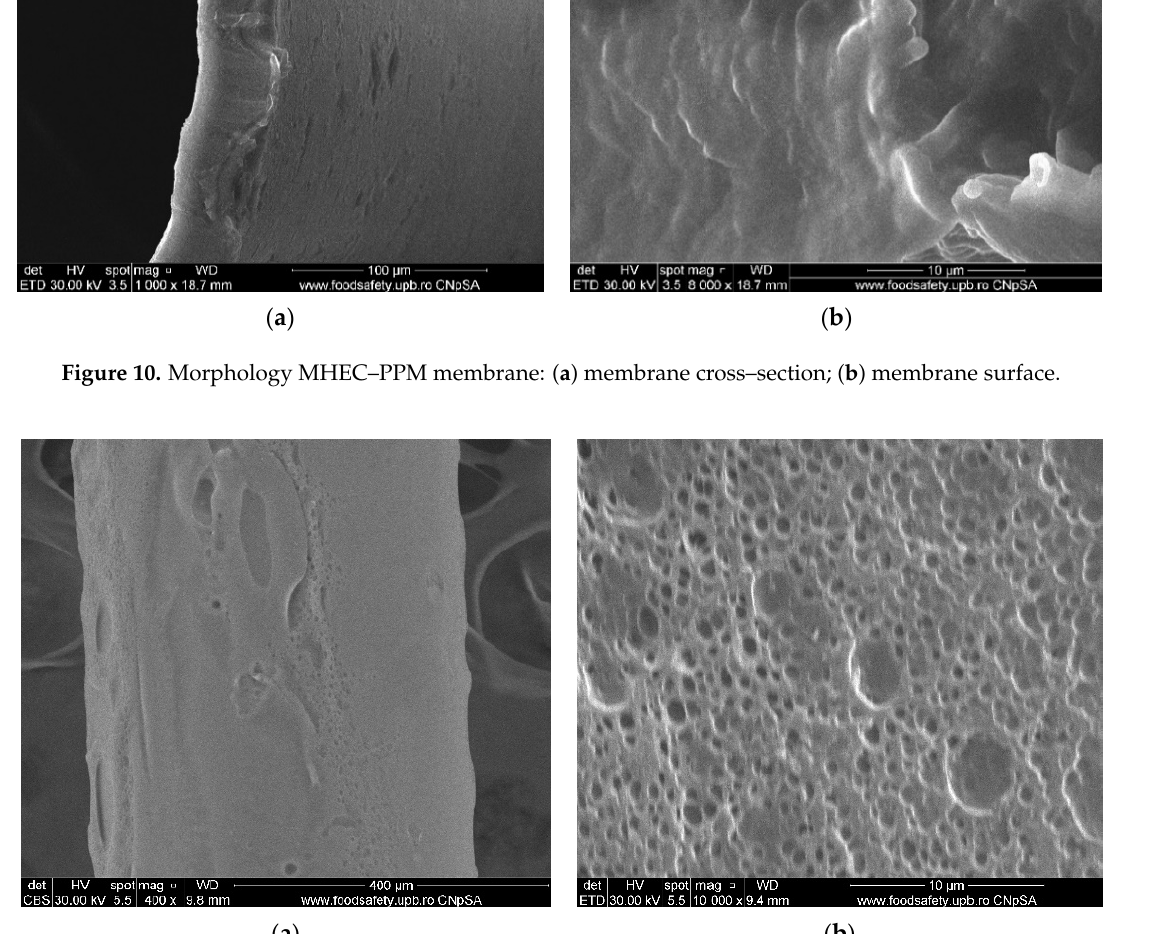
Figure 11. Morphology NaCMC–PPM membranes: ( a ) view; ( b ) membrane surface.